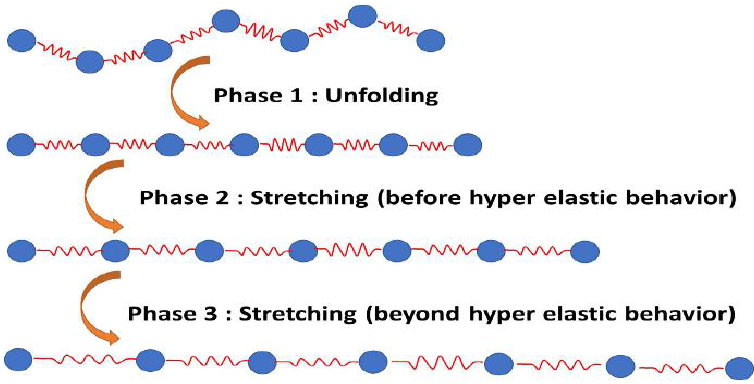
Figure 1. Tropocollagen molecule tensile